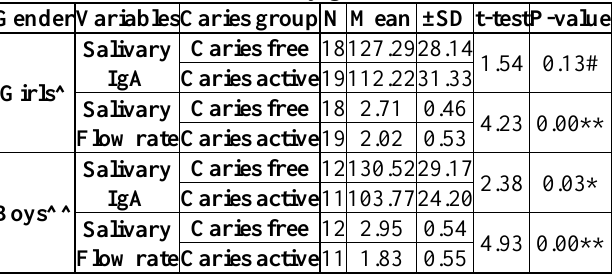
Table 2: Salivary IgA levels (mg/dl)and flow rate(ml/min)ofcaries free andcaries active